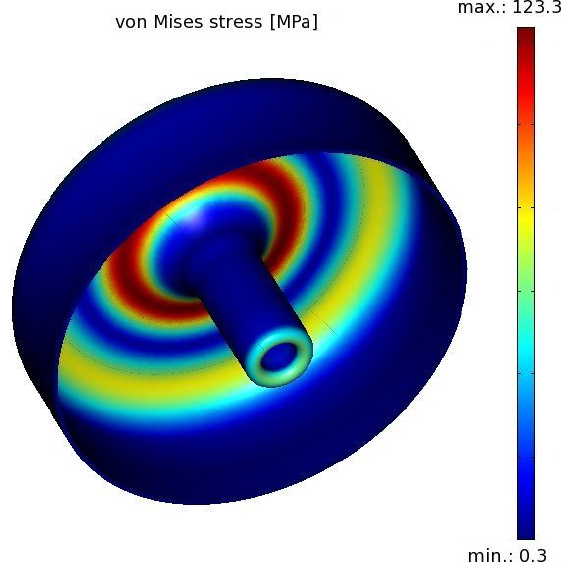
FIG. 39. (Color) The stress load distribution on the deformed end caps with an applied external force of 4 kN.